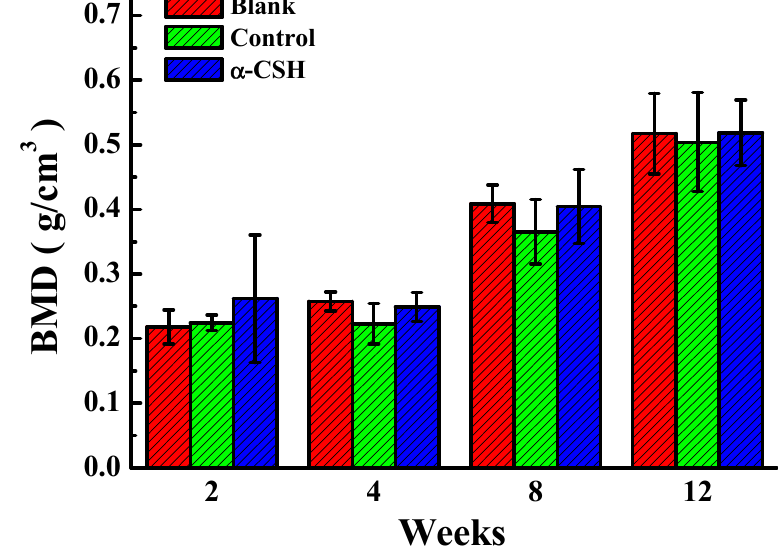
Figure 3. B one mineral density (BMD) measured by μ -CT evaluation at 2, 4, 8, and 12 weeks after Figure 3. Bone mineral density (BMD) measured by µ -CT evaluation at 2, 4, 8, and 12 weeks after treatment. ( p > 0.05). treatment. ( p >